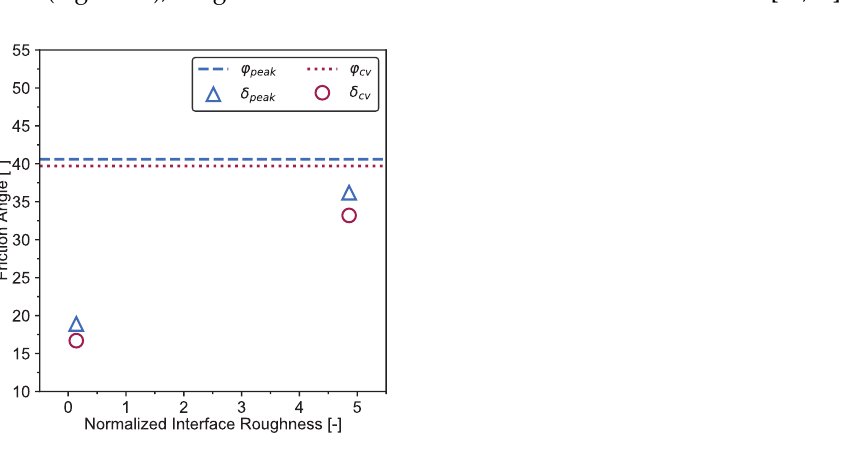
Figure 10. Summary of ( a ) peak and ( b ) residual failure envelopes for the three direct shear tests (soil-soil, smooth, and rough interfaces).